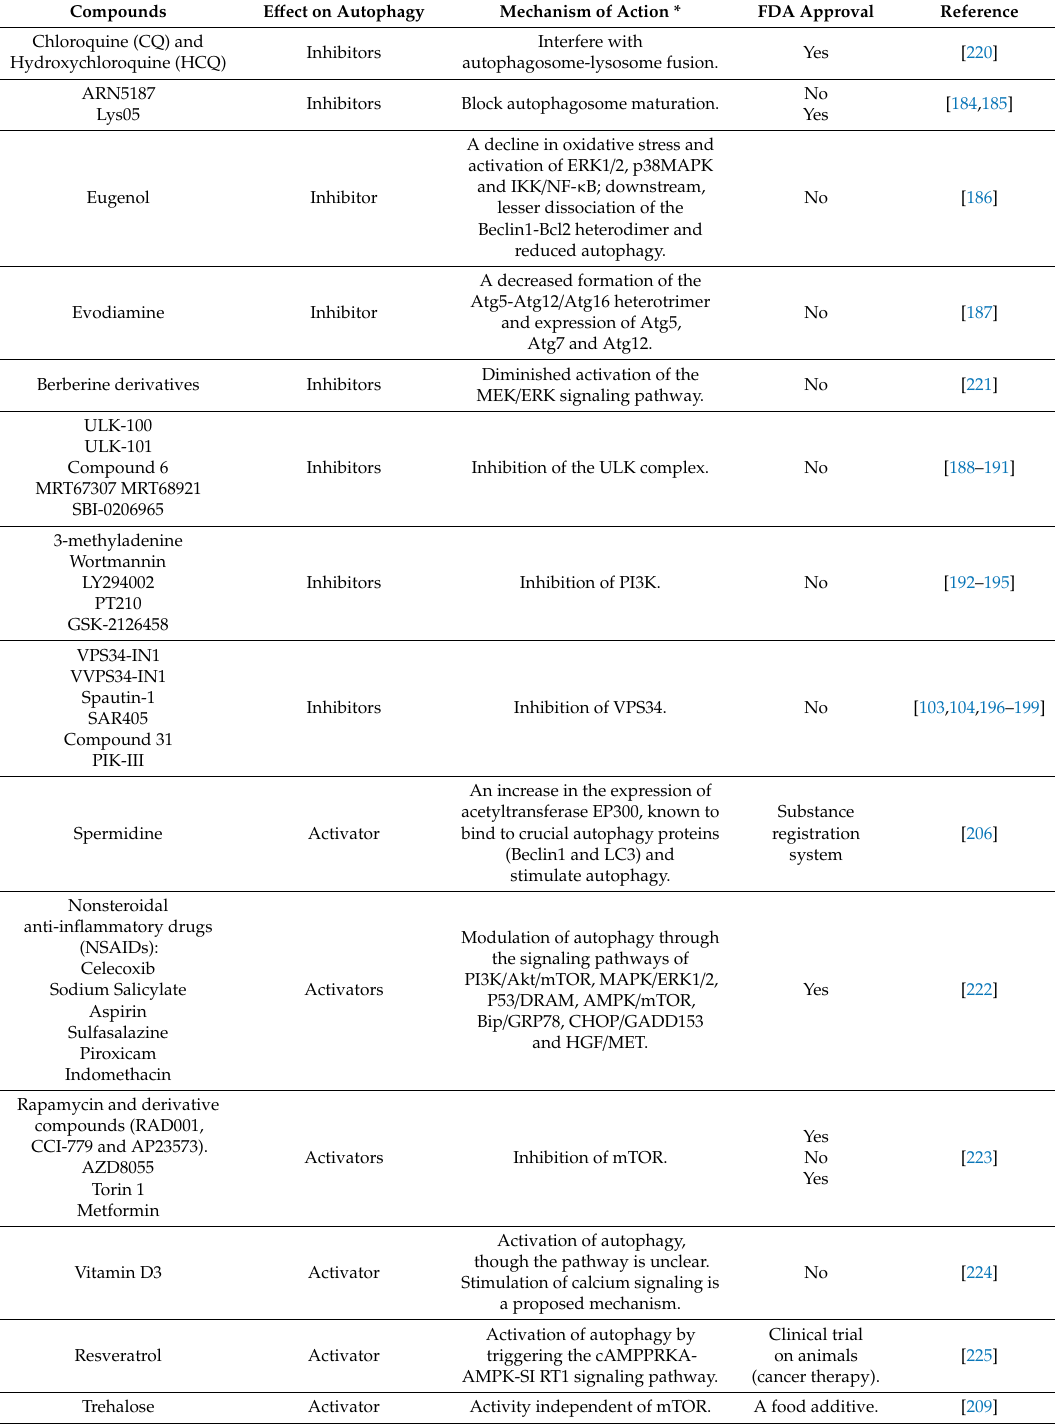
Table 2. Some compounds that a ff ect autophagy, with their respective mechanism of action.